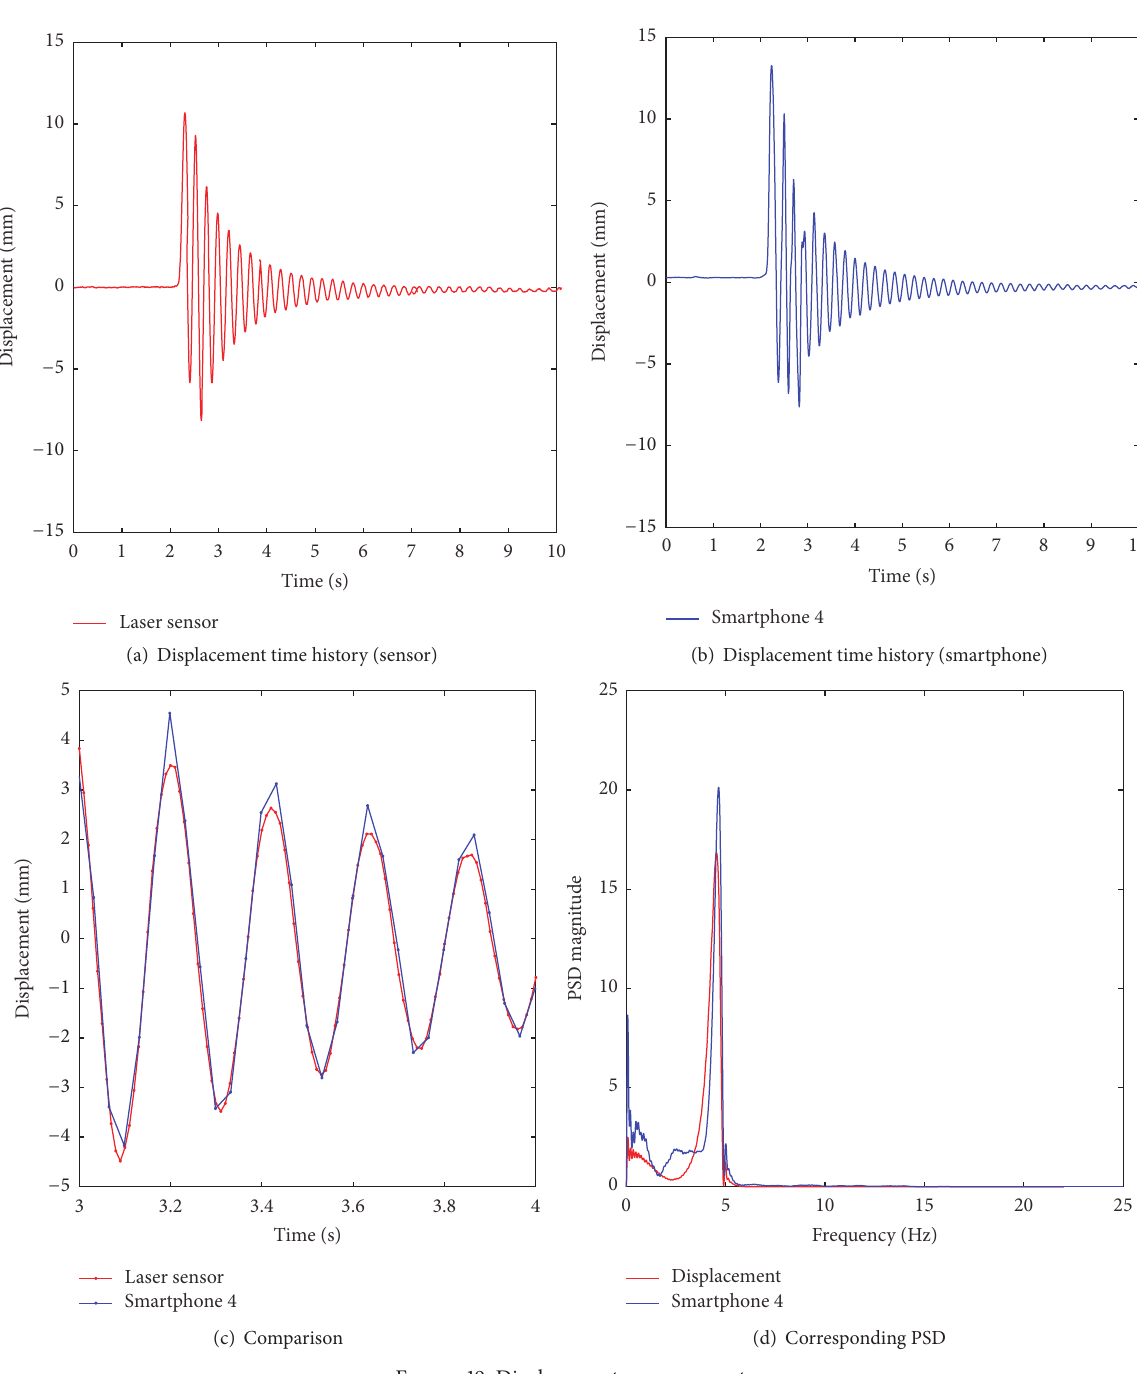
Figure 19: Displacement